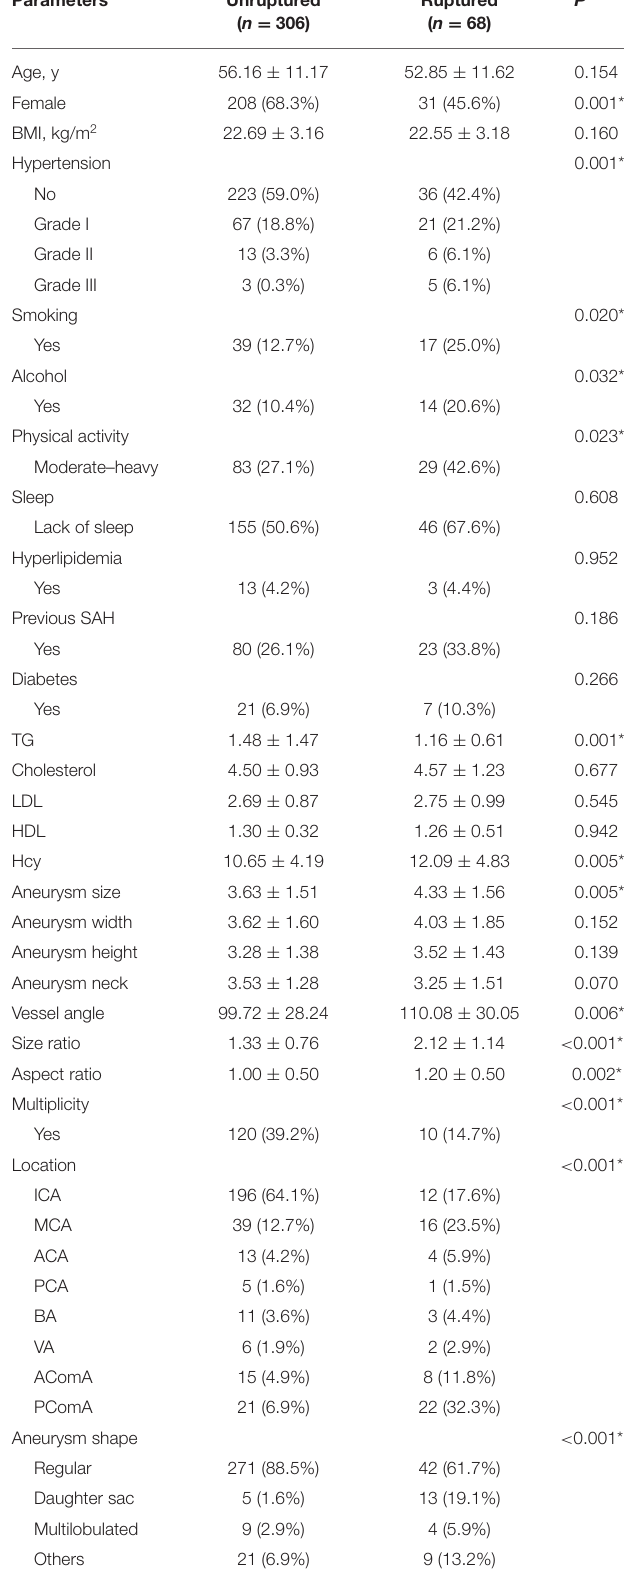
TABLE 1 | Results of univariate analysis for all feature variables.